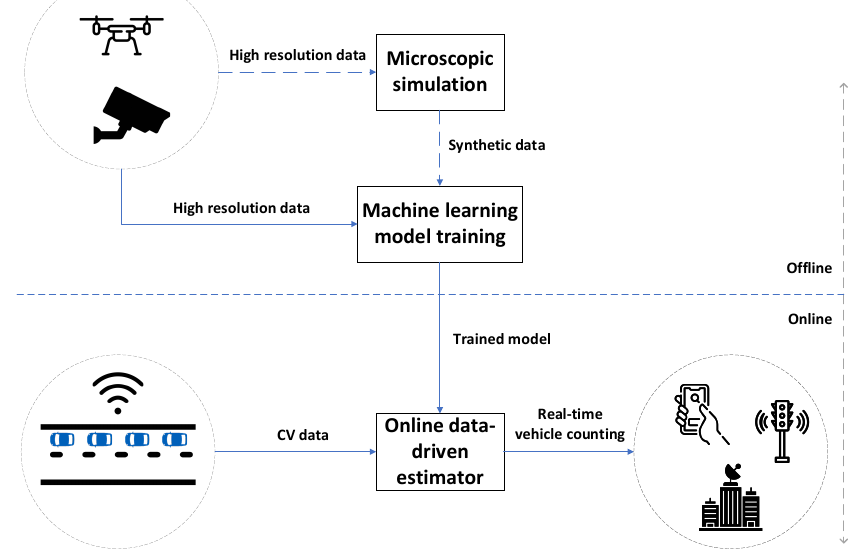
Figure 1. Illustration of the proposed estimation methodology. Note that employing microscopic simulation data is not strictly necessary and it may be used for model training if the high-resolution real data is deemed